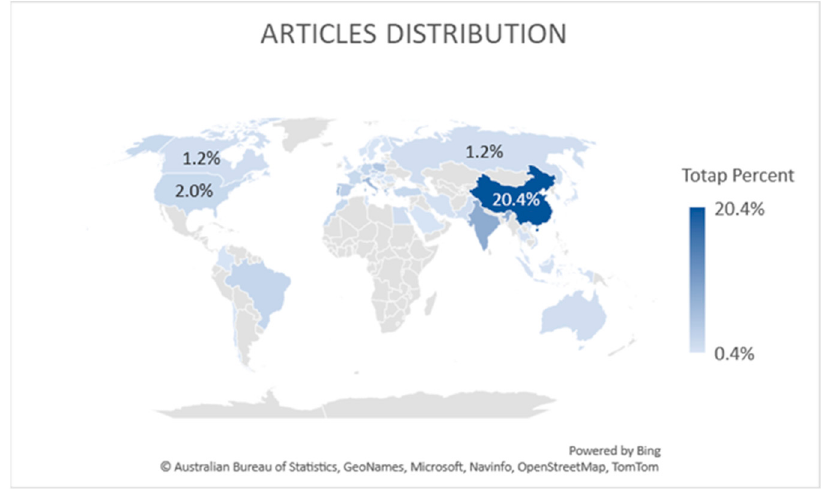
Figure 6. Article distribution.